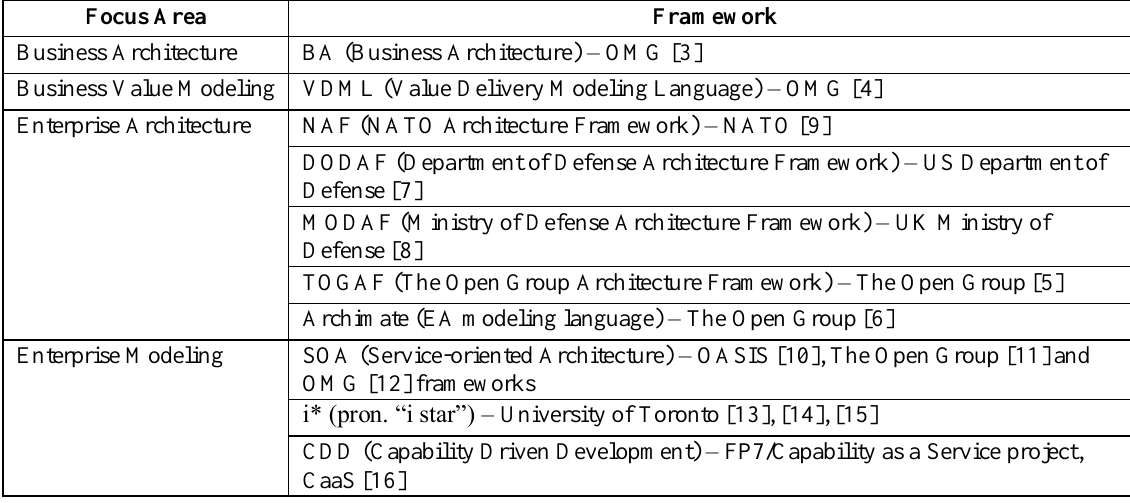
Table 1. The list of enterprise management frameworks included in the